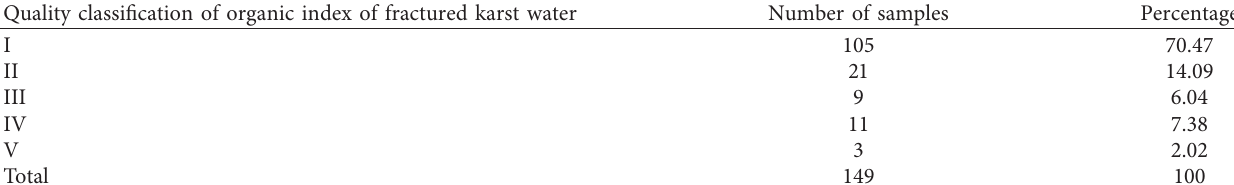
Table 6: Comprehensive quality evaluation of organic compounds of fractured karst water. Quality classification of organic index of fractured karst water